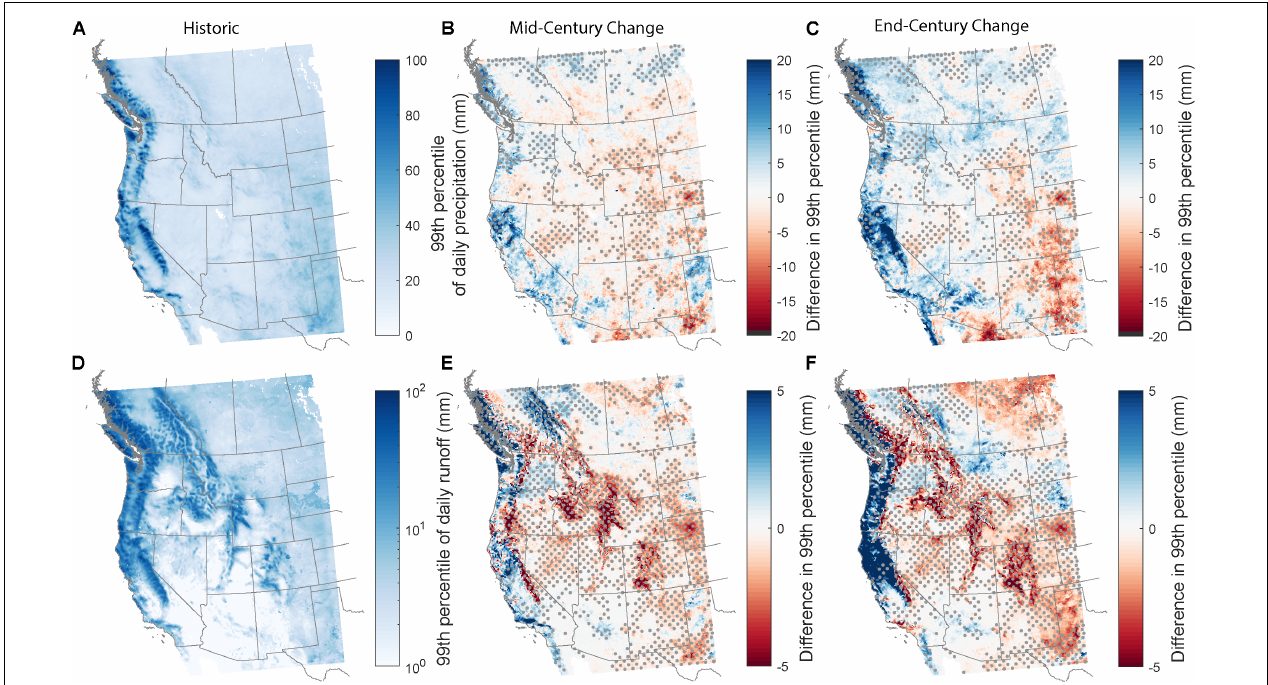
FIGURE 4 | (A) Grid cell values for the 99th percentile of daily precipitation for the WRF/CCSM historic decade. (B,C) Differences in magnitude of grid cell value of 99th percentile of daily precipitation when comparing the mid-century (B) and end-century (C) decades to the historic decade. (D–F) Same as (A–C) but for the 99th percentile of daily runoff. Stippling indicates regions with a statistically significant change by mid- or end-century at the 95% confidence level.